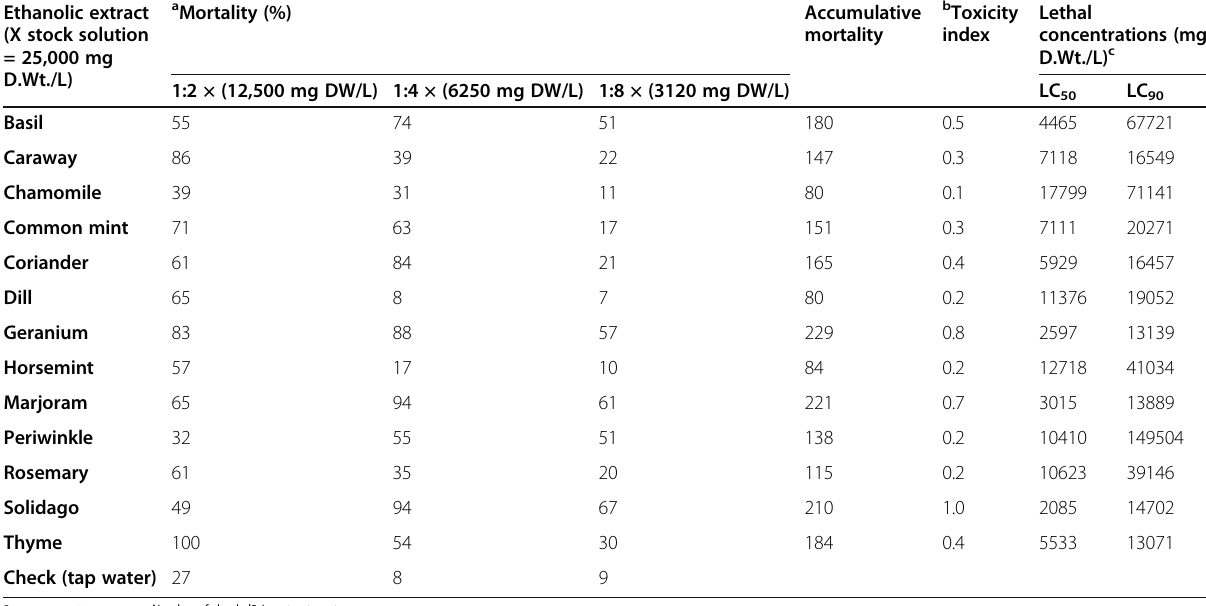
Table 3 Mortality percentages of M. incognita J2 as influenced by dry leaves ethanolic extracts of selected medicinal plants at different dilutions Ethanolic extract (X stock solution = 25,000 mg D.Wt./L)